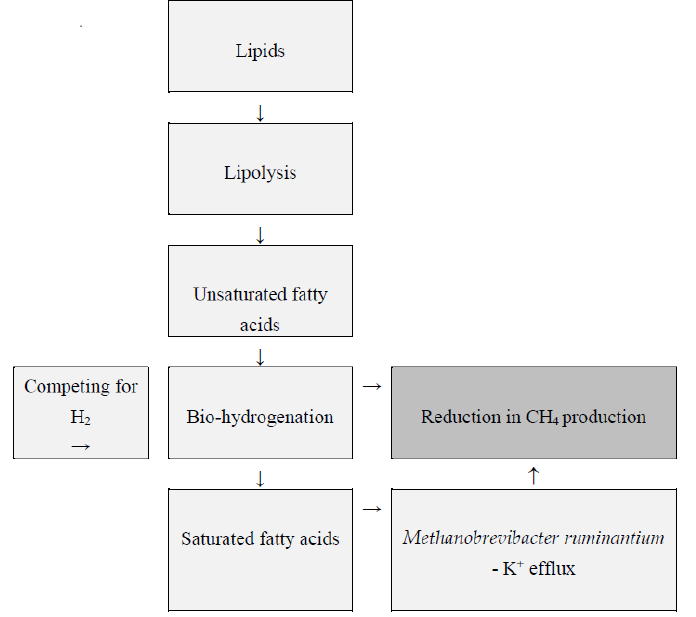
Figure 3. Rumen lipid metabolism and CH 4 production according to Zhou et al. [100] and Klevenhusen et al. [101].